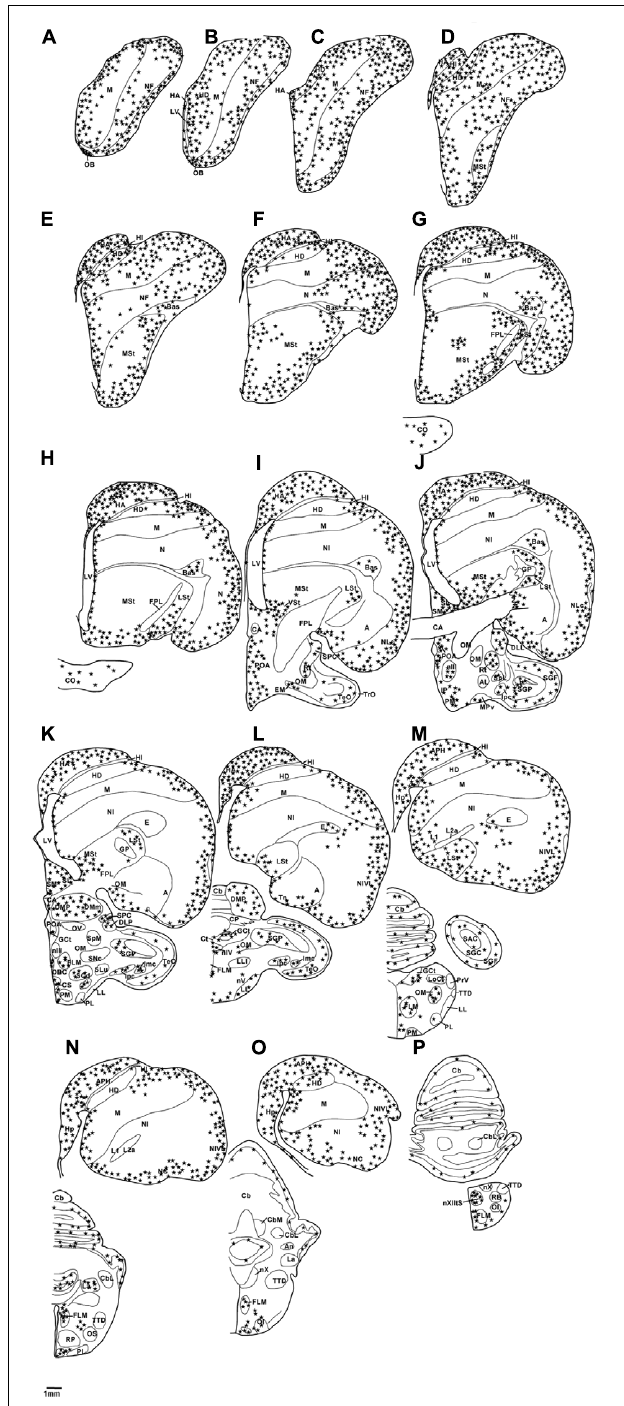
FIGURE 2 | Diagrammatic reconstructions of a series of evenly spaced coronal sections through one half of the brain of the African grey Parrot, illustrating the distribution of DCX-immunoreactive cells. A single solid black star indicates a single cell body and a single open star represents a weakly stained cell. Drawing (A) represent the most rostral section, (P) the most caudal, and each drawing is approximately 1,500 µ m apart. For example distance between A,B is 1,500 µ m. The same applies for B–P . See list for